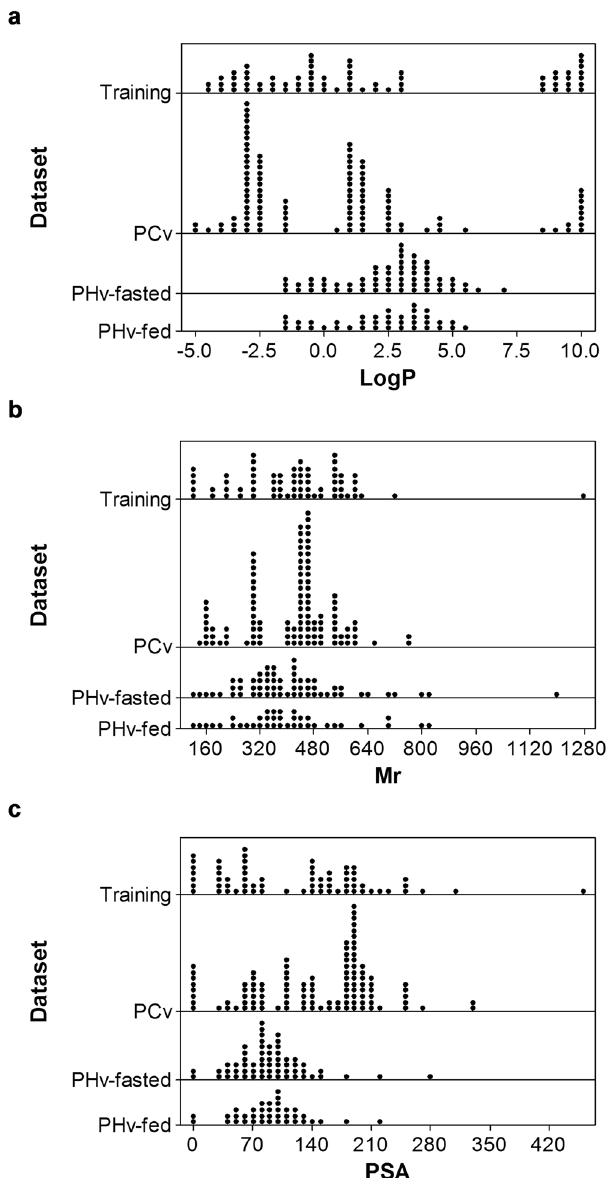
Figure 2. Summary of variables included in datasets for the development and validation of the predictive model. Dot plots demonstrate distributions of ( a ) log P, ( b ) M r and ( c ) PSA of four datasets: training (N = 67), PCv (N = 108), PHv-fasted (N = 60) and PHv-fed (N = 38)